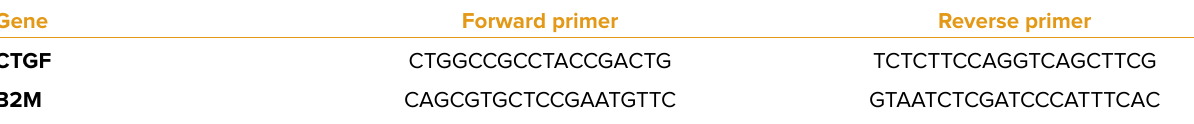
Table 1. Sequences of the designed primers.